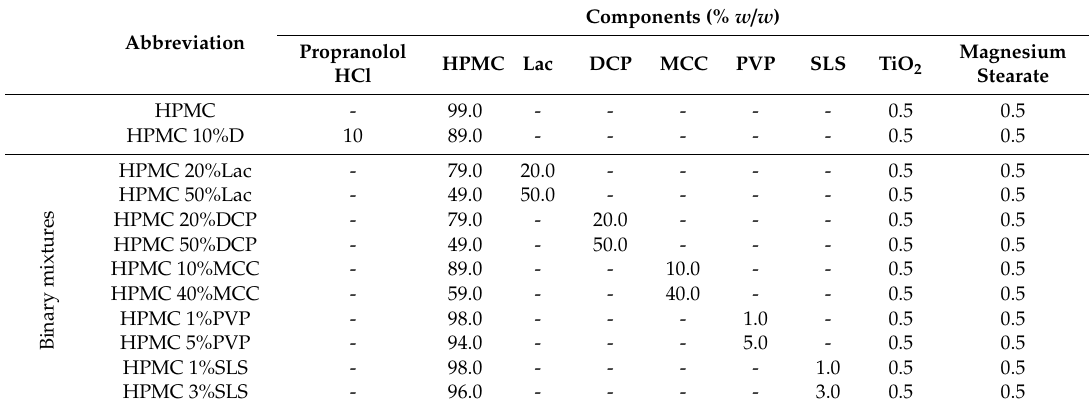
Table 2. Composition of HPMC-based matrix formulations.